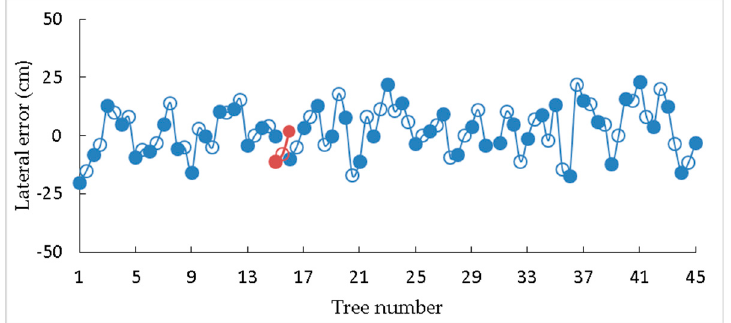
Figure 13. The change in lateral error in the second test.